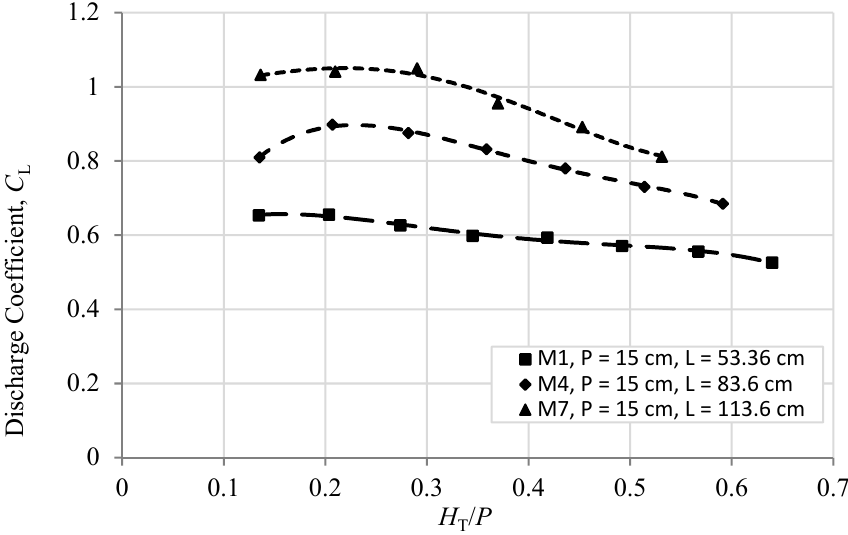
Figure 20. Discharge coefficient, C L , vs. H T /P for models M1, M4, and M7.